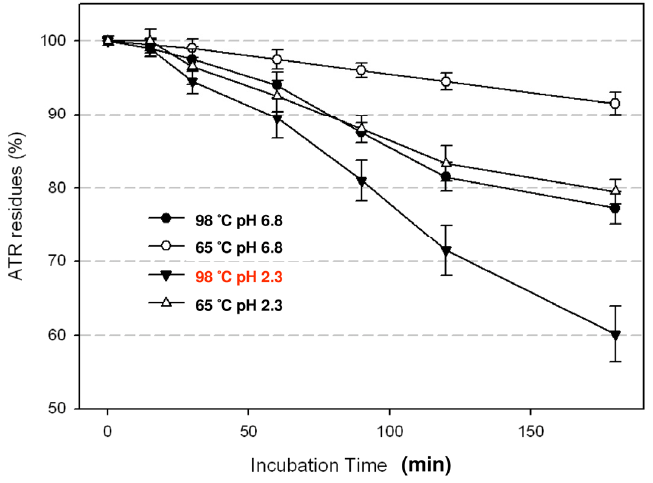
Figure 6. The degradation of ATR by acidification and heating. After acidification and heating for 120 min, the residue of ATR is decreased significantly (the p value is less